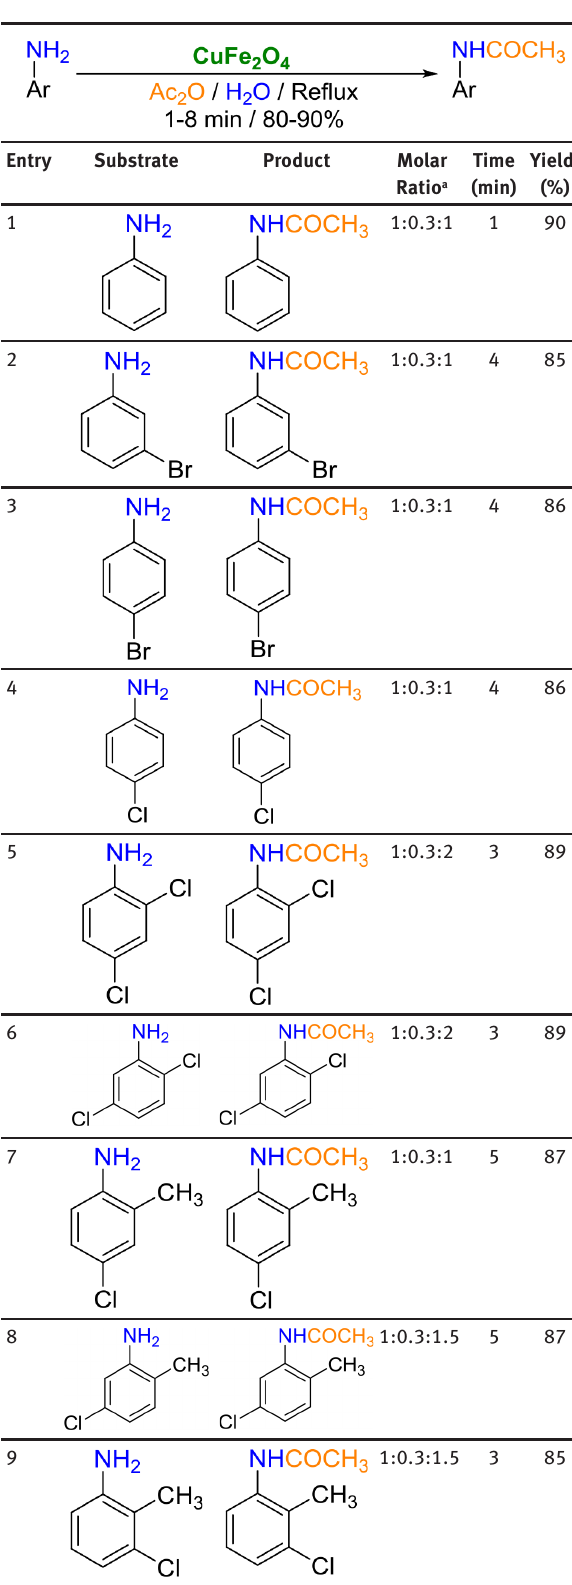
Table 1: Optimization experiments for the N -acetylation of aniline to acetanilide.